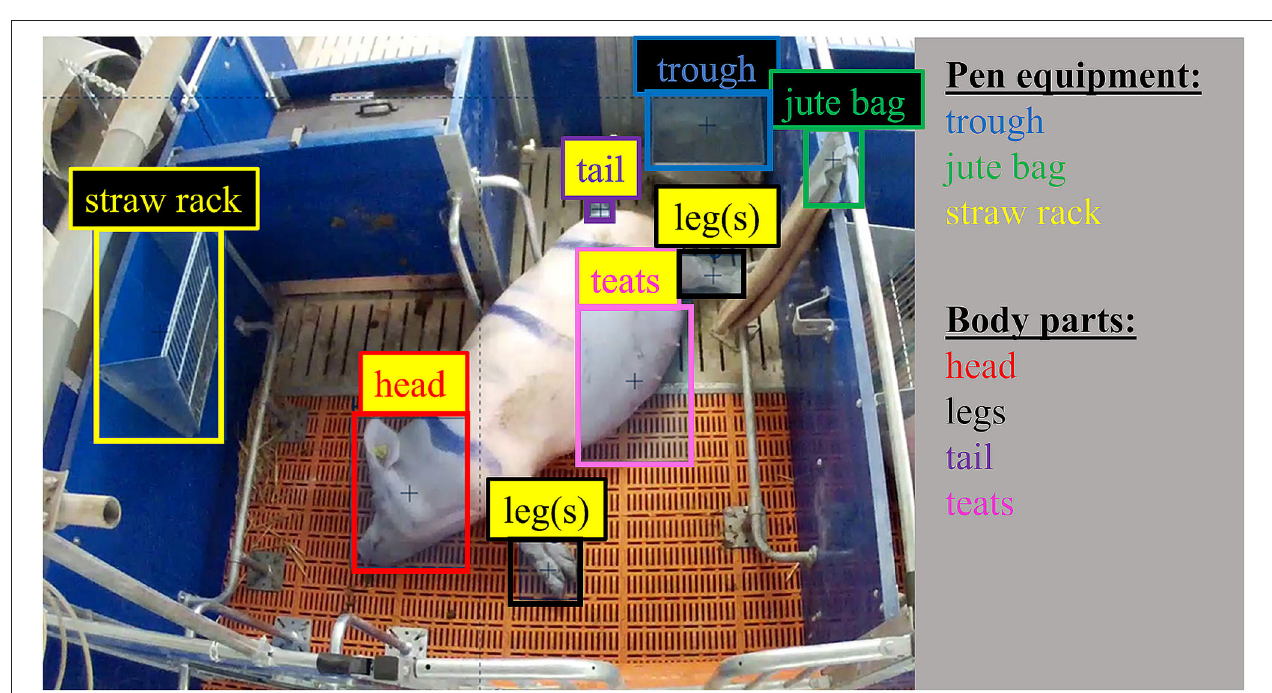
FIGURE 2 | Example of an annotated image (old pen) from the data set with Ybat [Edited to highlight the annotated pen equipment (black background) and body parts of the sow (yellow background)].